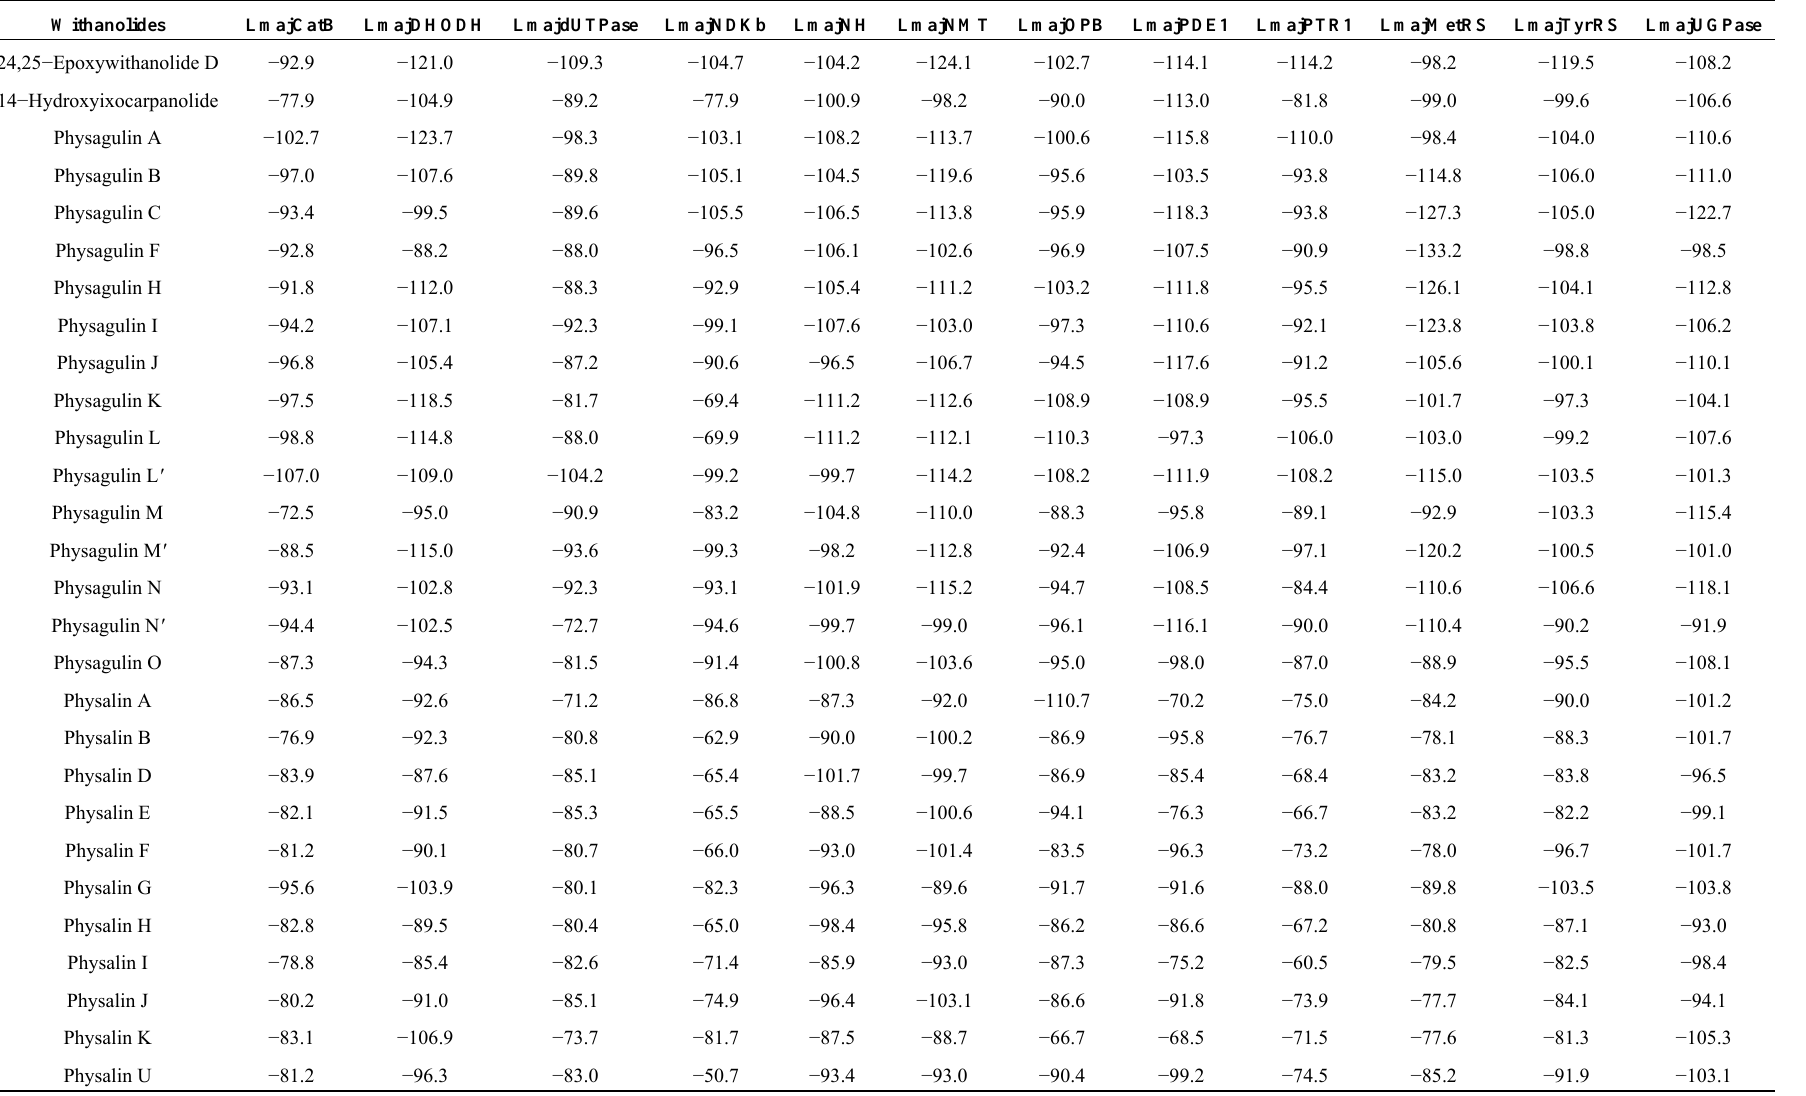
Table 32. MolDock docking energies (kJ/mol) of withanolides with Leishmania major protein